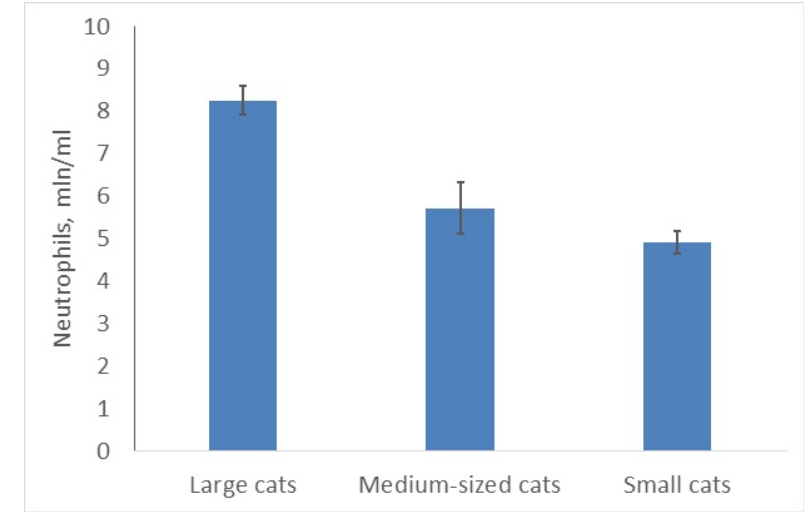
Figure 2. Larger felids have more neutrophils than smaller ones.